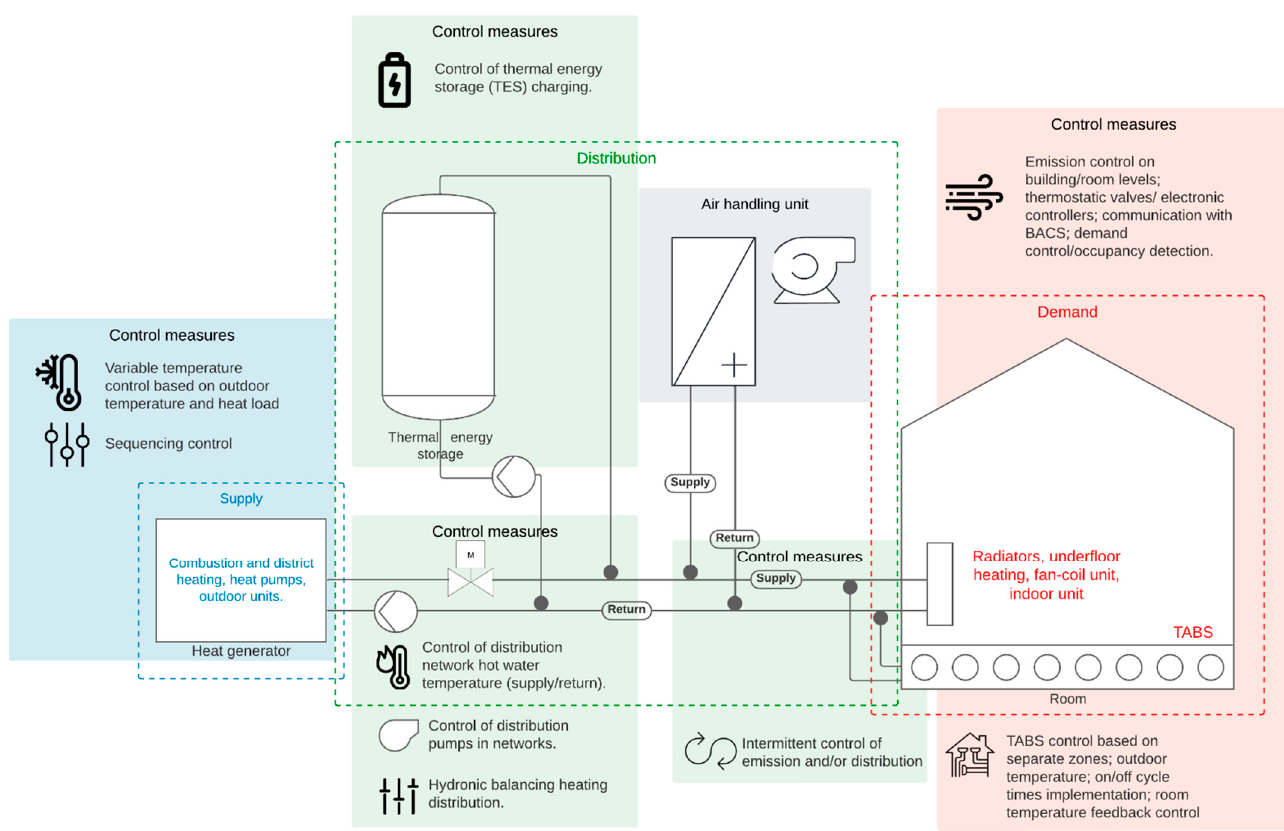
Figure 1. Space heating system and available control measures. Adapted from ISO 52120 ‐ 1:2022